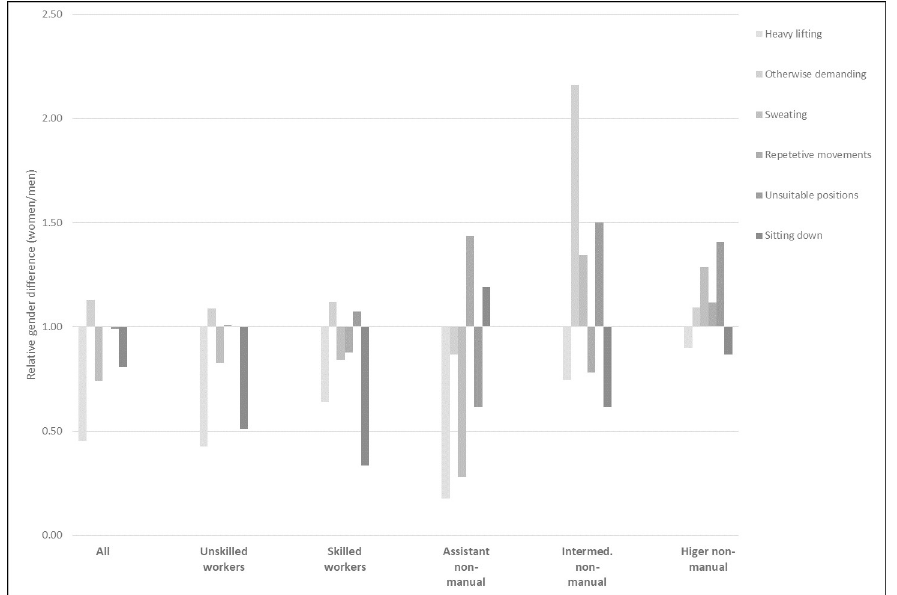
Fig 1. Gender differences in physically strenuous work, by class. Relative differences (percentage share women/ percentage share men). Differences > 1 indicate that the condition is more common among women than among men, differences < 1 indicate that the condition is more common among men than among